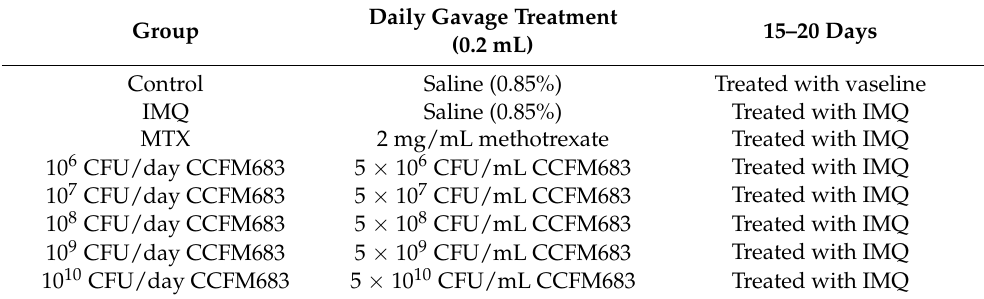
Table 1. Animal Experiment Design.